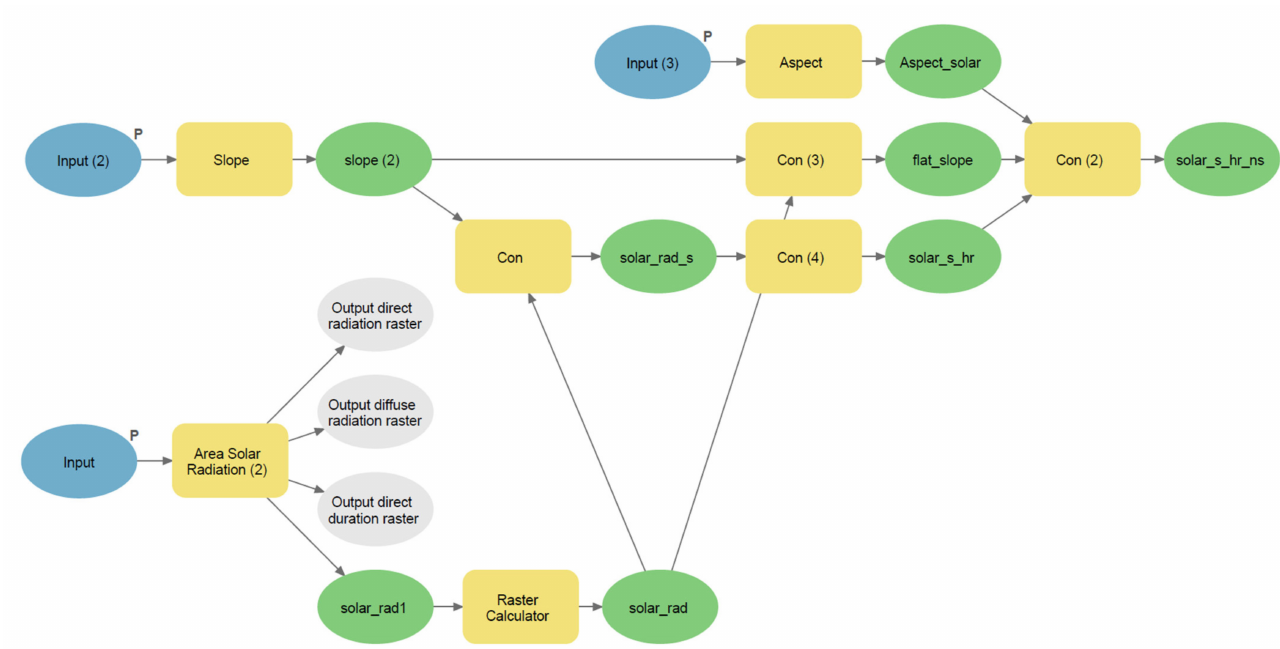
Figure 5. The analysis model built using the ArcGIS Pro